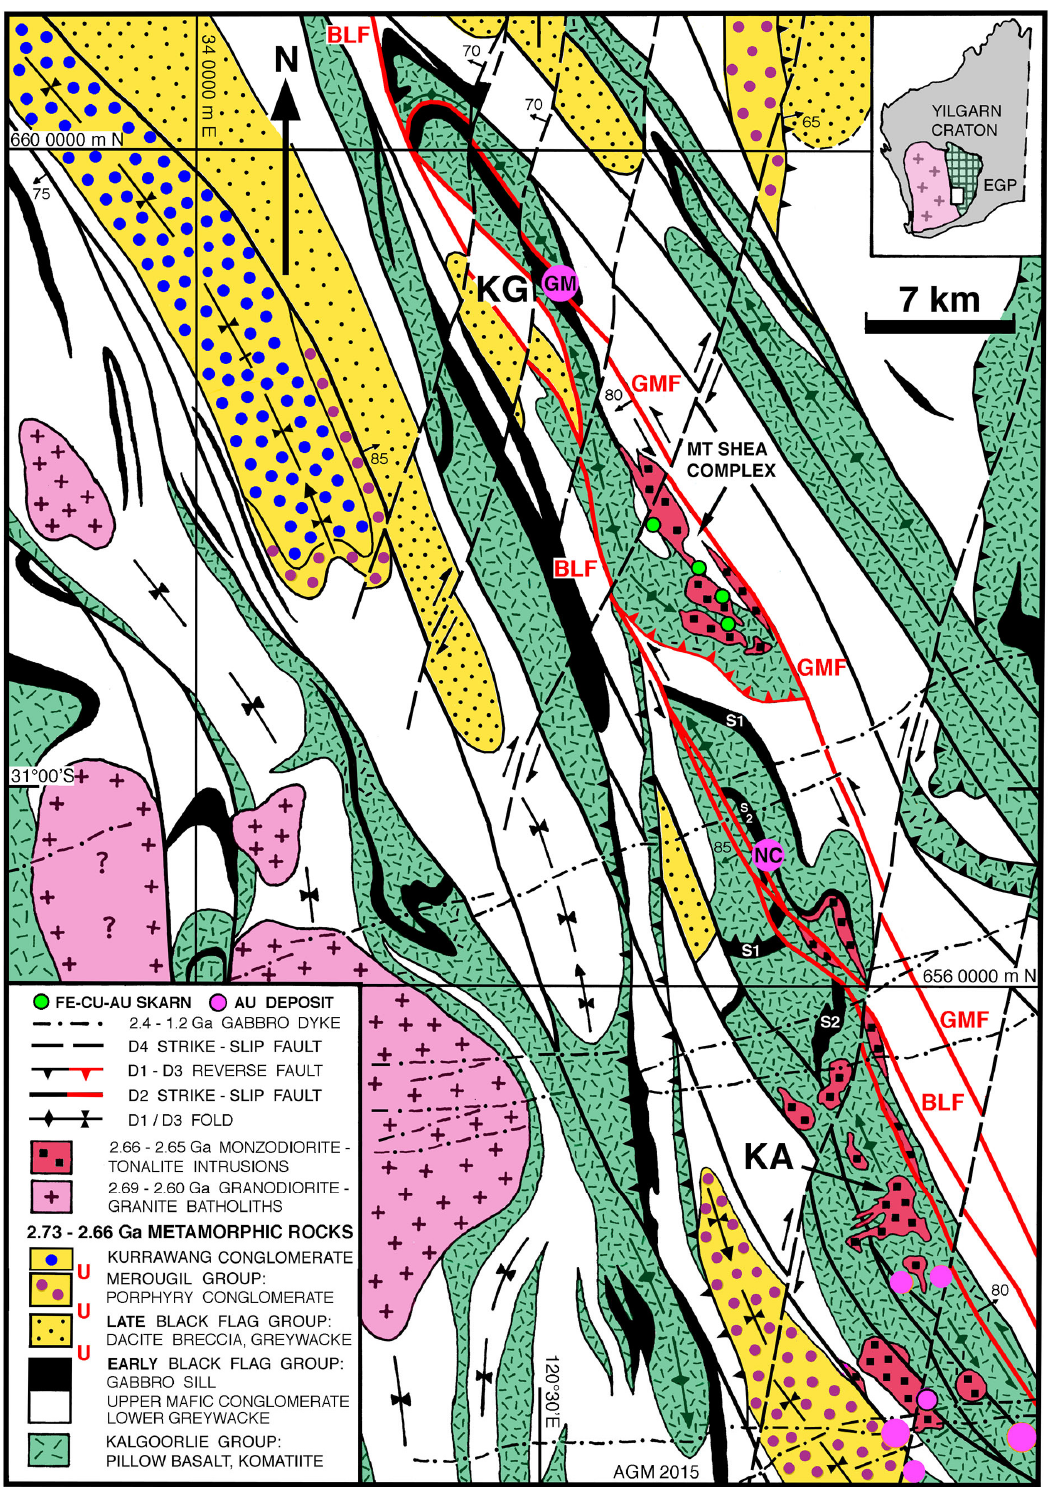
Figure 1. Geologic map of the southern Kalgoorlie Terrane showing the Boulder Lefroy-Golden Mile strike-slip fault system (BLF-GMF; in red), the folded stratigraphic units (U = unconformity) in the Kalgoorlie (KG)-Kambalda (KA) area, the locations of the Golden Mile (GM) and New Celebration (NC) mesothermal gold deposit, the Mt Shea monzodiorite-tonalite complex and associated Fe-Cu-Au skarns, and other gold deposits southeast of Kambalda (modified from [5]). Note the 12 km left lateral offset of metagabbro sills (S1; S2) at the Boulder Lefroy Fault. The UTM coordinates are Map Grid Australia (MGA) 1994, Zone 51. The inset of Western Australia shows the map area in the Eastern Goldfields Province (EGP) of the Yilgarn Craton.